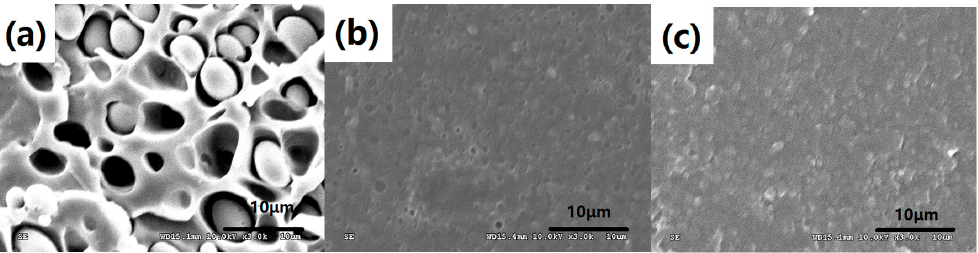
Figure 6. SEM micrographs of quenched PLA/TPEE specimens with and without ADR: ( a ) PLA/TPEE (80/20); ( b ) PLA/TPEE/ADR (80/20/0.5); ( c ) PLA/TPEE/ADR (80/20/1.0).